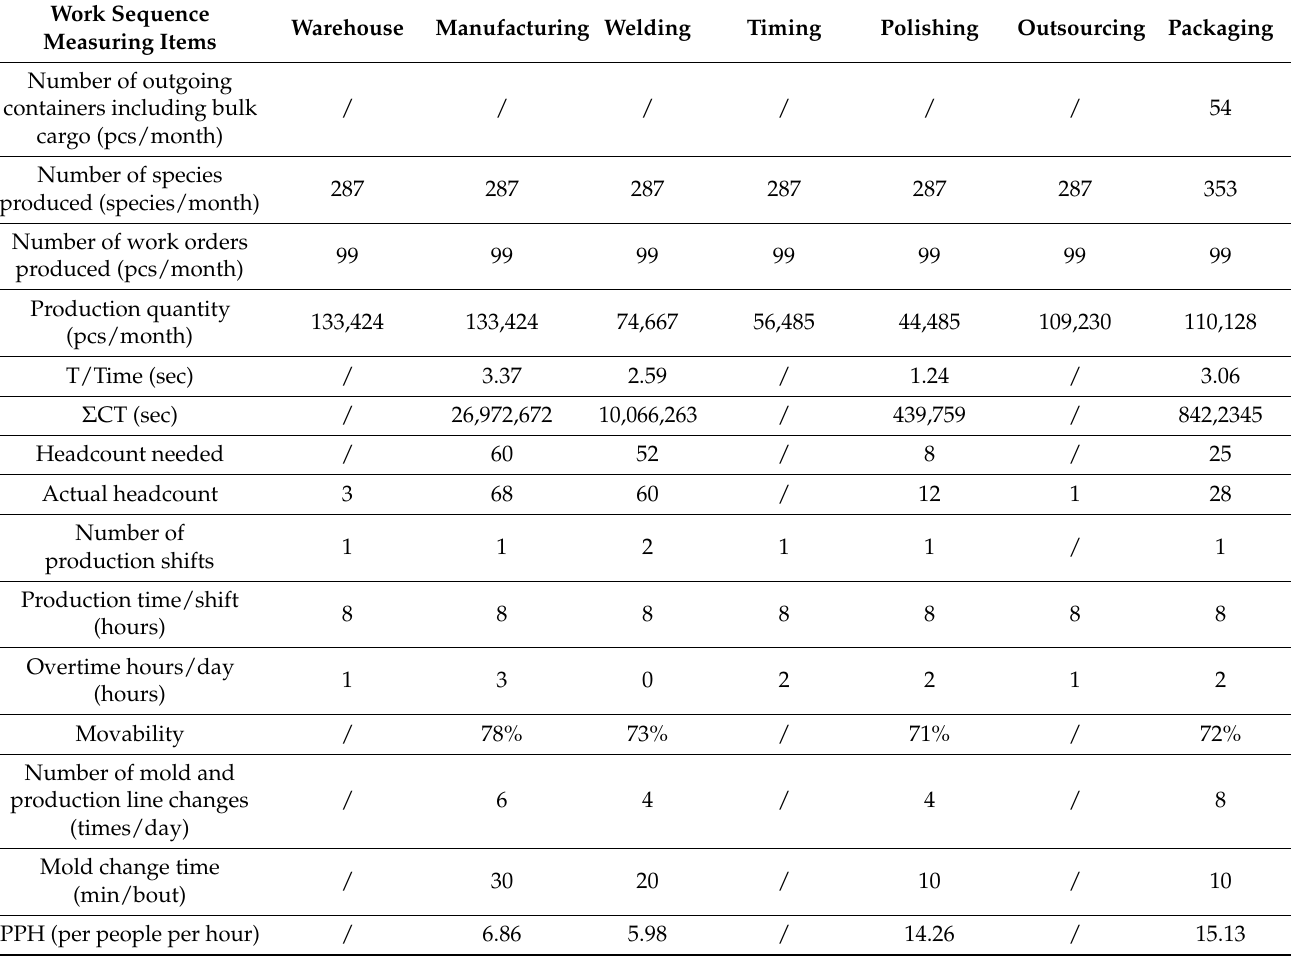
Table 1. Production site survey